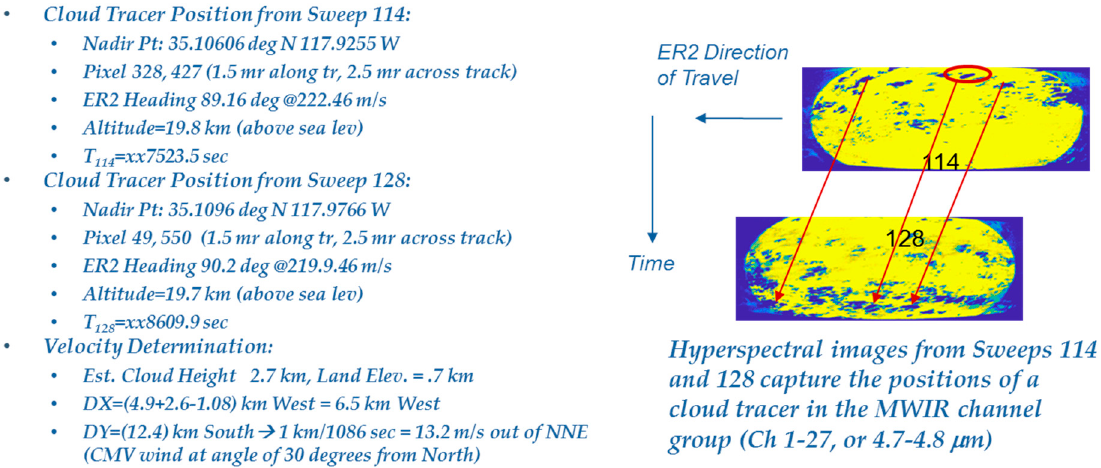
Figure 11. Cloud positions observed from the MISTiC airborne instrument over Edwards Air Force Base during two over-passes, allowing determination of the cloud motion vector wind velocity at cloud level. cloud